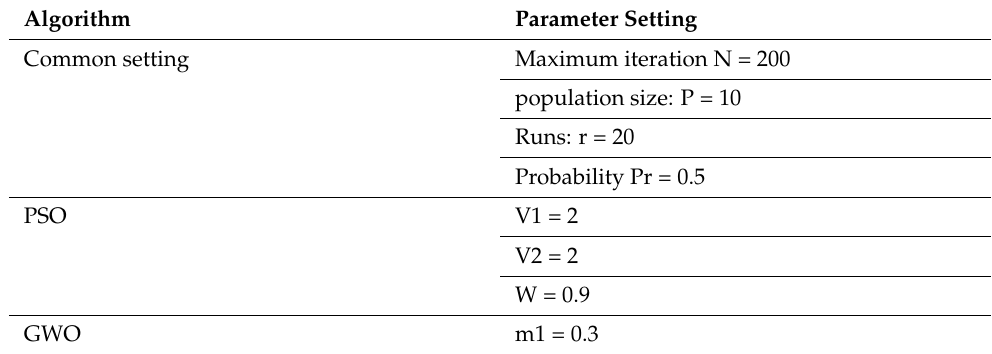
Table 1. Parameter value of PSO, GWO, WOA, BES, and